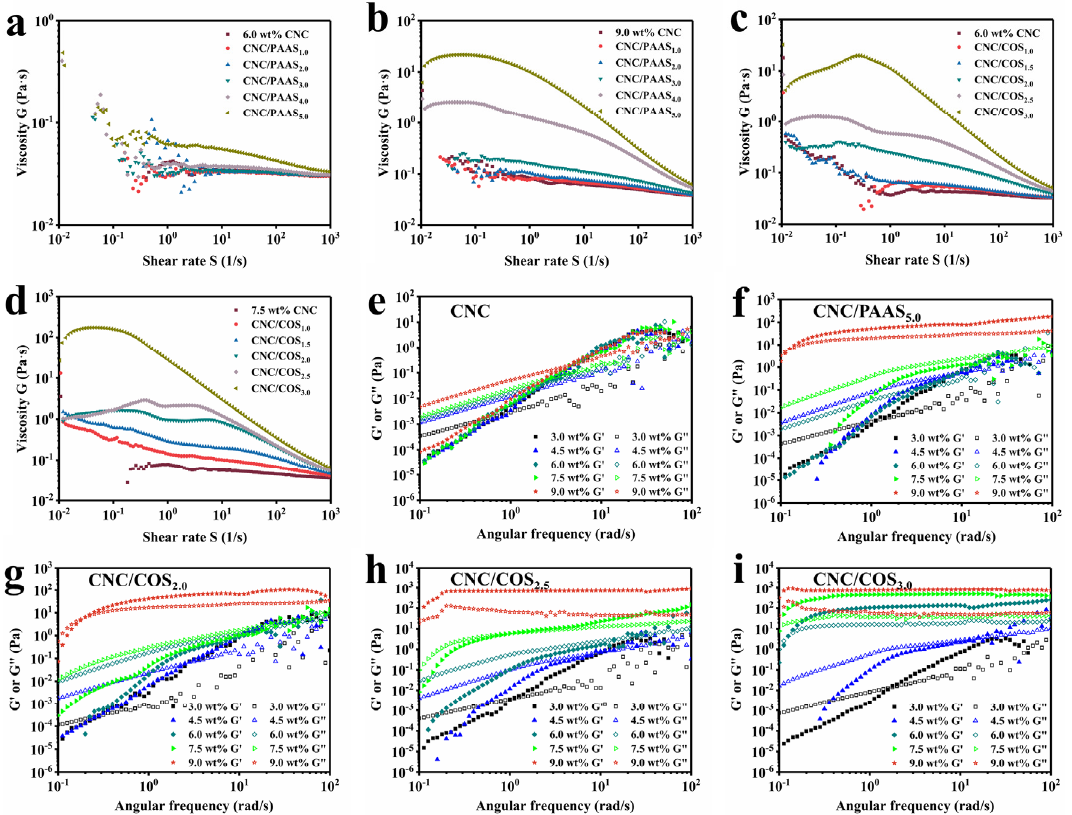
Figure 5. The steady viscosity of CNC/PAAS mixtures at ( a ) 6.0 wt% and ( b ) 9.0 wt% concentration, respectively. The steady viscosity of CNC/COS mixtures at ( c ) 6.0 wt% and ( d ) 7.5 wt% concentration, respectively. Dependence of storage modulus (G ′ ) and loss modulus (G ″ ) as a function of the angular frequency for ( e ) CNC suspension, ( f ) CNC/PAAS mixtures with 5.0 wt% PAAS addition, and CNC/COS mixtures with ( g ) 2.0 wt%, ( h ) 2.5 wt%, and ( i ) 3.0 wt% COS addition.